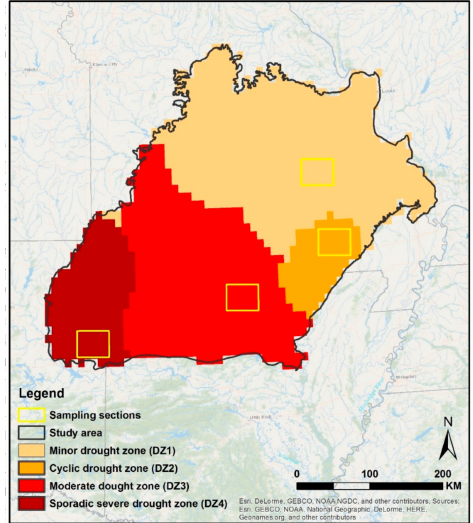
Figure 4. Four drought zones were extracted by Isodata procedure from the first six